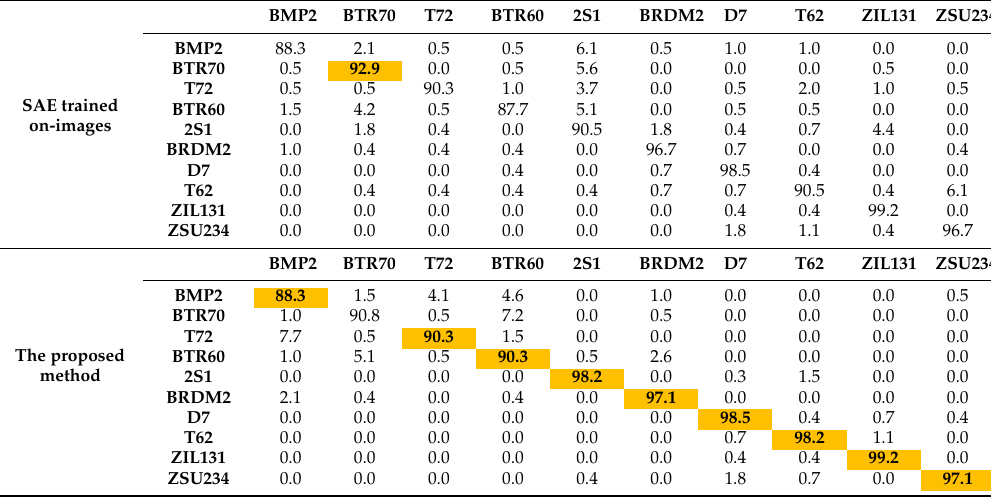
Table 6. The 10-class targets confusion matrices of two